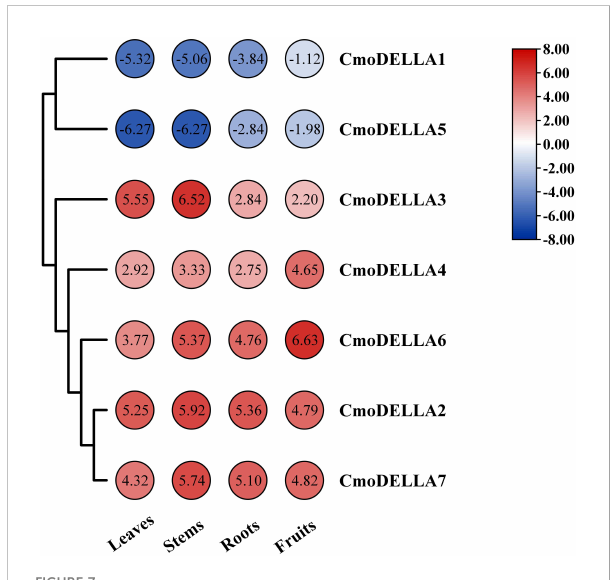
FIGURE 7 Transcriptional levels of CmoDELLA genes in the different tissues (leaves, stems, roots and fruits). The transcriptional levels are normalized by the reads per kilobase of exon per million reads mapped (RPKM) method. The red color represents the higher expression, while the blue color indicates the lower